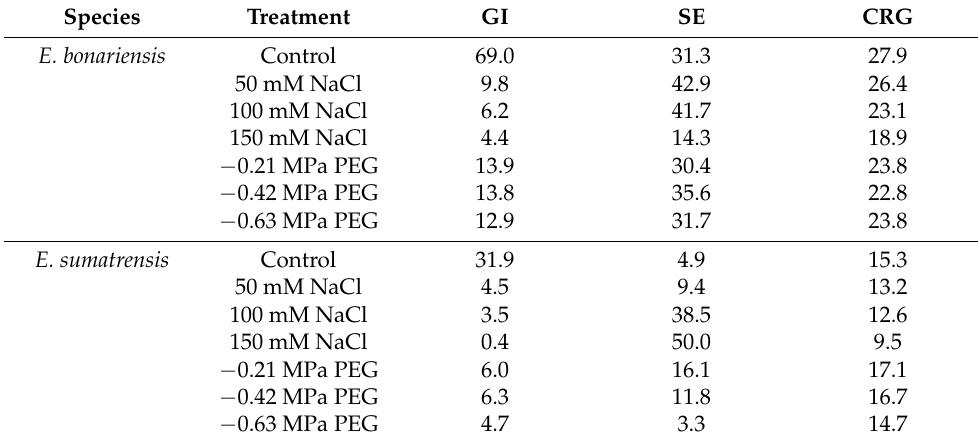
Table 1. Germination indices calculated for different treatments in the two Erigeron species: GI— germination index; SE—speed of emergence; CRG—coefficient of germination speed. Species Treatment GI SE